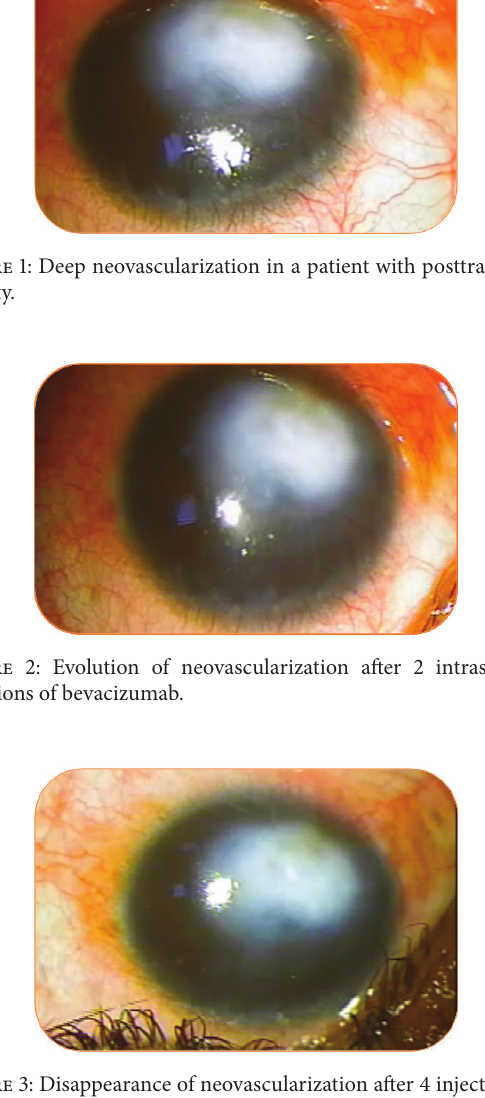
Table 1: Clinical grading method of the corneal neovascularization in the degree of invasion of new blood vessels in the central cornea.